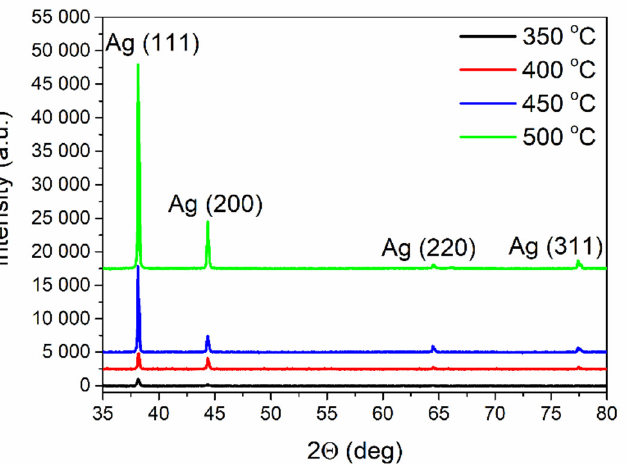
Figure 4. ( a ) Absorbance spectra of as-synthesized and Na + –Ag + ion-exchanged PTR-M glass samples after heat treatment at 500 ◦ C for different durations measured after removing the SNIF. ( b ) The differential absorbance spectra obtained by subtracting the spectrum of the as-synthesized sample from the others.